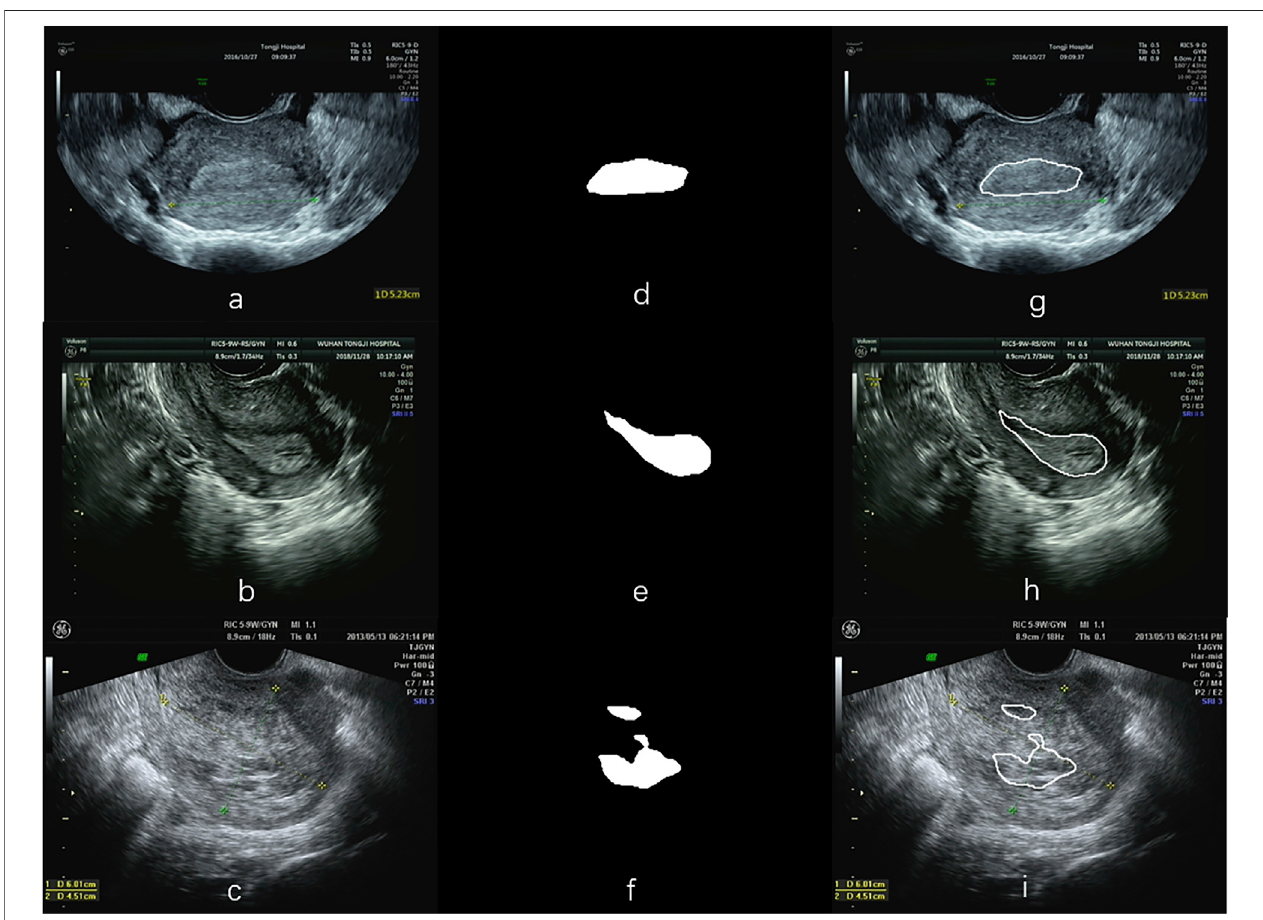
FIGURE 6| Examples of segmentation using the ResNet50-SegNet model. (A – C) are the original images, (D – F) the segmented endometrial masks, and (G – I) the segmentation results in the original images.